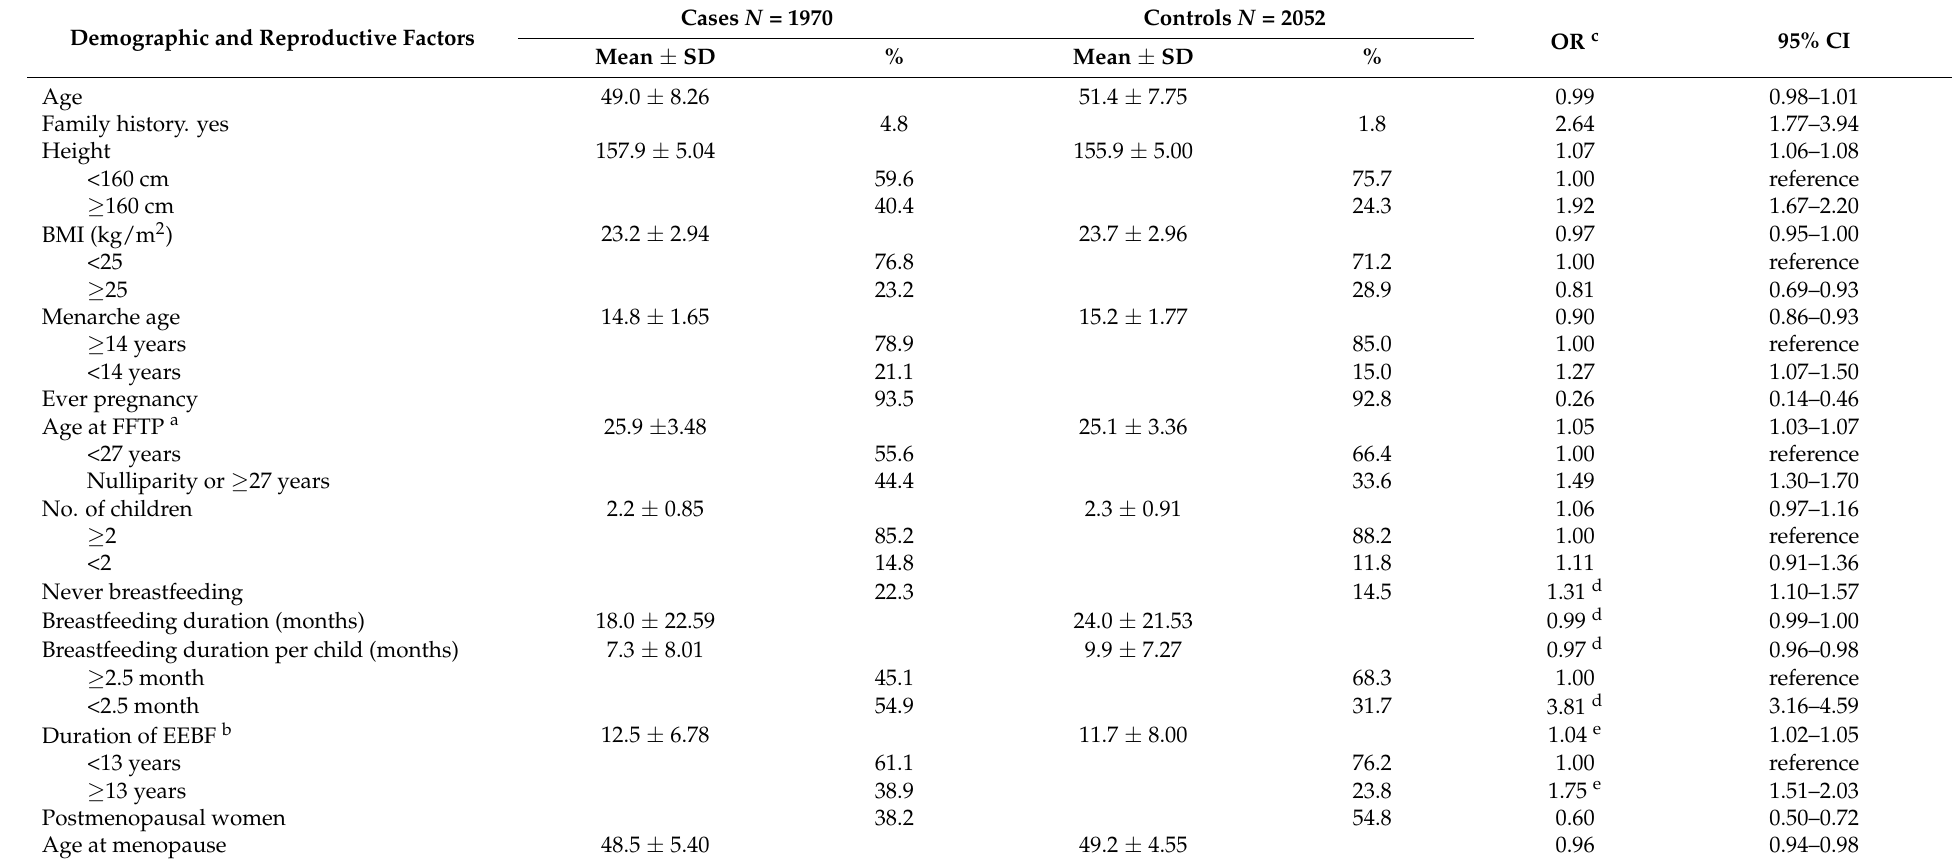
Table 1. Distributions of demographic and reproductive factors and associations with the risk of breast cancer, Seoul Breast Cancer